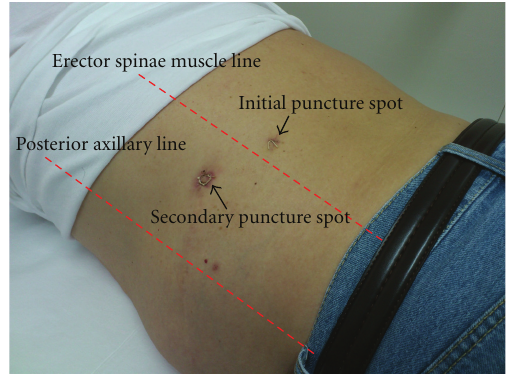
Figure 3: Initial puncture spot at skin is too dorsally.